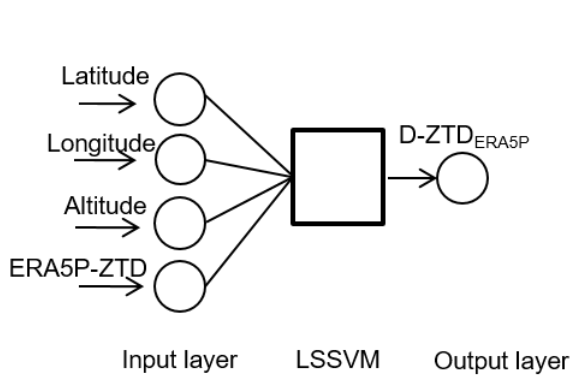
Figure 3. Network structure of Scheme 3.